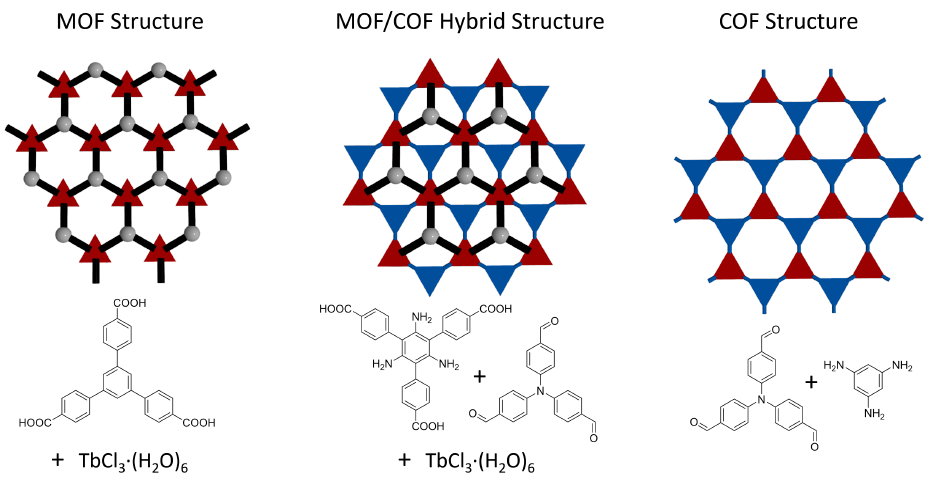
Figure 1. Schematic representation of the conversion of a MOF to a COF. The first step is to synthesize the MOF. The hybrid MOF/COF structure is the cross-linked MOF. The COF is achieved by removing the metals out of the